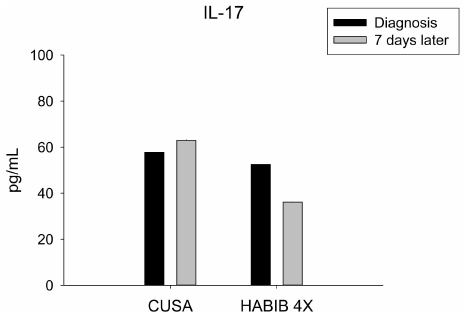
Figure 6. Serum IL-17 level changes in both study groups. Significant decrease was noted in Habib TM 4X